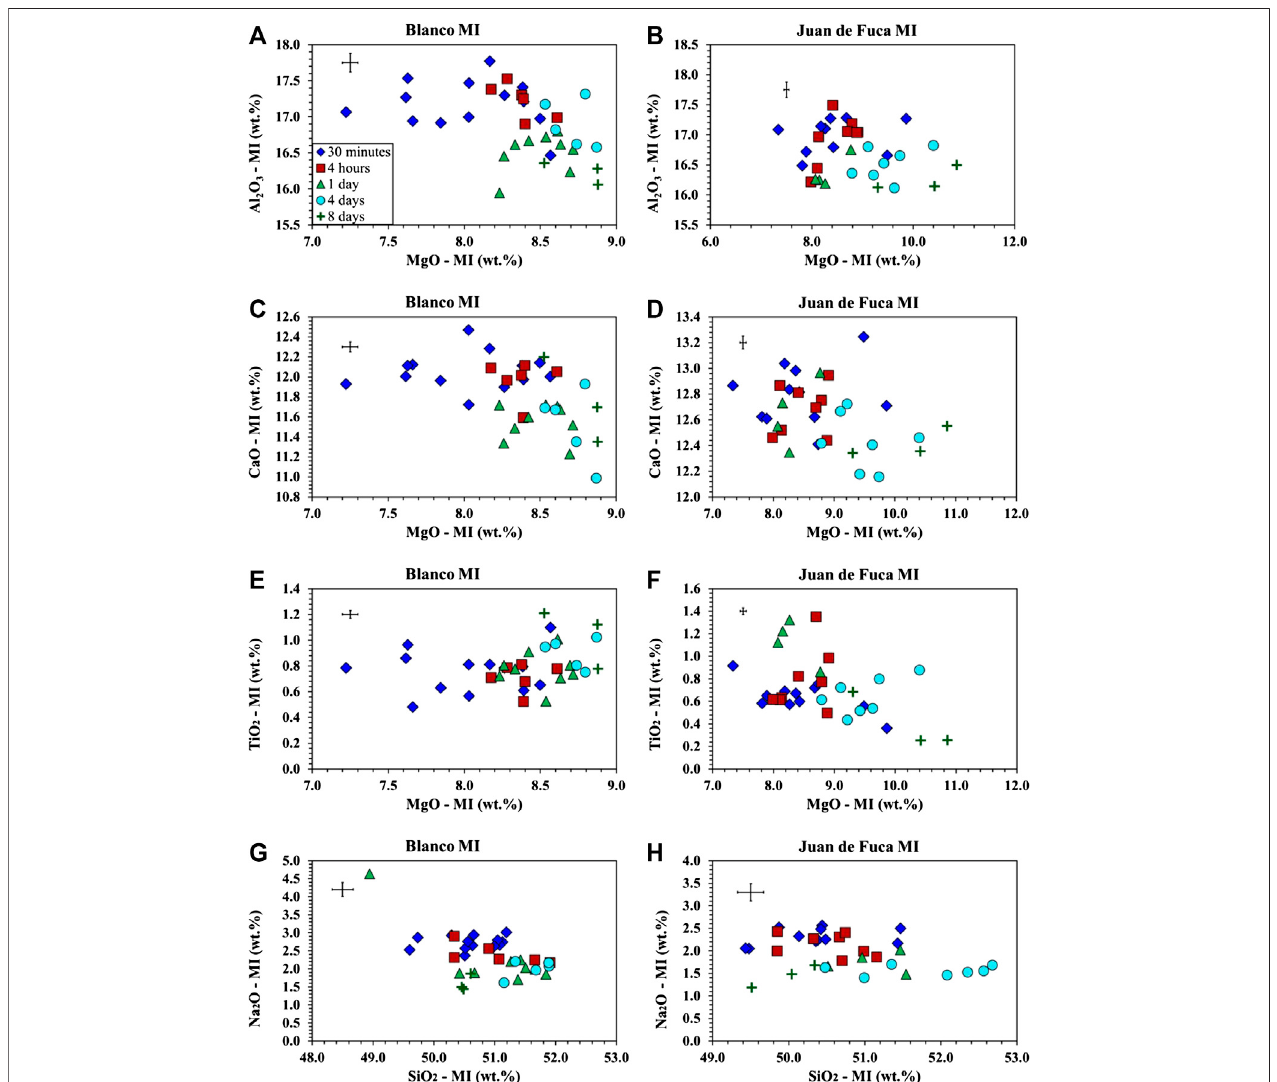
FIGURE 1 | Major element analysis of MIs from the Juan de Fuca Ridge (D23-2) and the Blanco Fracture Zone (A91-1R1) samples following homogenization at 1 bar. Symbols for run time is consistent across all major element plots with 30 min as blue diamonds, 4 h as red squares, 1 day as green triangles, 4 days as aqua circles,and8 daysasdarkgreencrosses.Errorbarsarelocatedintheupperlefthandcornerofeachplot. (A) Al 2 O 3 vs.MgOforA91-1R1(BlancoFractureZone)shows adecreaseinAl 2 O 3 andanincreaseinMgOwithtime. (B) Al 2 O 3 vs.MgOforD23-2(JuandeFuca)showsadecreaseinAl 2 O 3 andanincreaseinMgOwithtime. (C) CaO vs. MgO for A91-1R1 (Blanco Fracture Zone) shows a decrease in CaO and an increase in MgO. (D) CaO vs. MgO for D23-2 (Juan de Fuca) shows a decrease in CaO andanincreaseinMgO. (E) TiO 2 vs.MgOforA91-1R1(BlancoFracture Zone)correlatingTiO 2 andMgO. (F) TiO 2 vs.MgOfortheD23-2(JuandeFuca)correlating TiO 2 and an increase in MgO. (G) Na 2 O vs. SiO 2 for A91-1R1 (Blanco Fracture Zone) shows a decrease in Na 2 O and an increase in SiO 2 outside of 8 days experiments. (H) Na 2 O vs. SiO 2 for D23-2 (Juan de Fuca) shows a decrease in Na 2 O and an increase in SiO 2 outside of 8 days